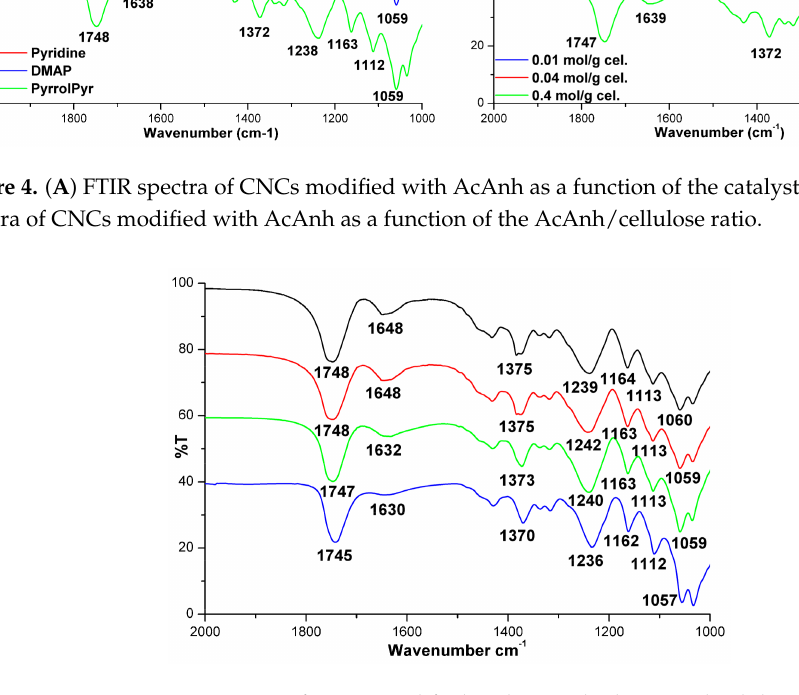
Figure 5. FTIR spectra of CNCs modified with AcAnh; the reproducibility